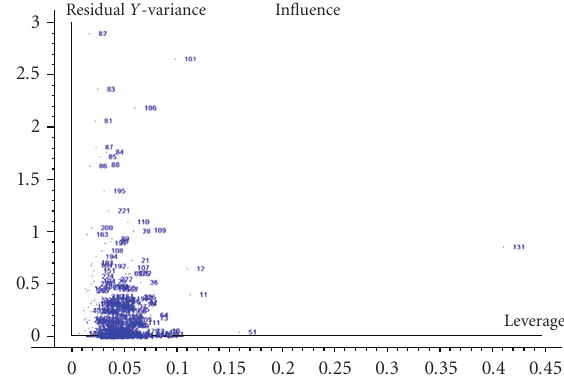
Figure 4: Residual Y -variance influence plot for calibration